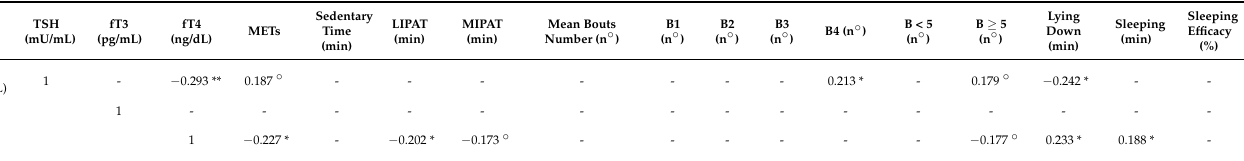
Table 2. Significant correlations of thyroid hormones with physical activity and sleeping parameters, adjusting for the effects of age, CRP and MMI.